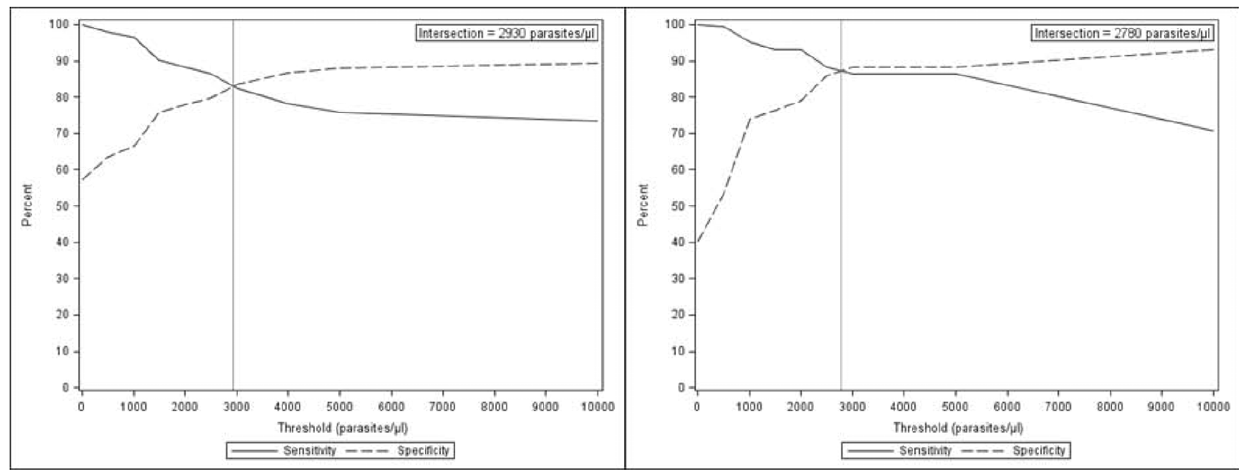
Figure 5. Malaria case definition using objective fever according to the season. a. Sensitivity and specificity of alternative parasite threshold for malaria case definition in the high transmission season using objective ( . =37.5 degrees C) fever. b. Sensitivity and specificity of alternative parasite threshold for malaria case definition in the low transmission season using objective ( . =37.5 degrees C) fever.